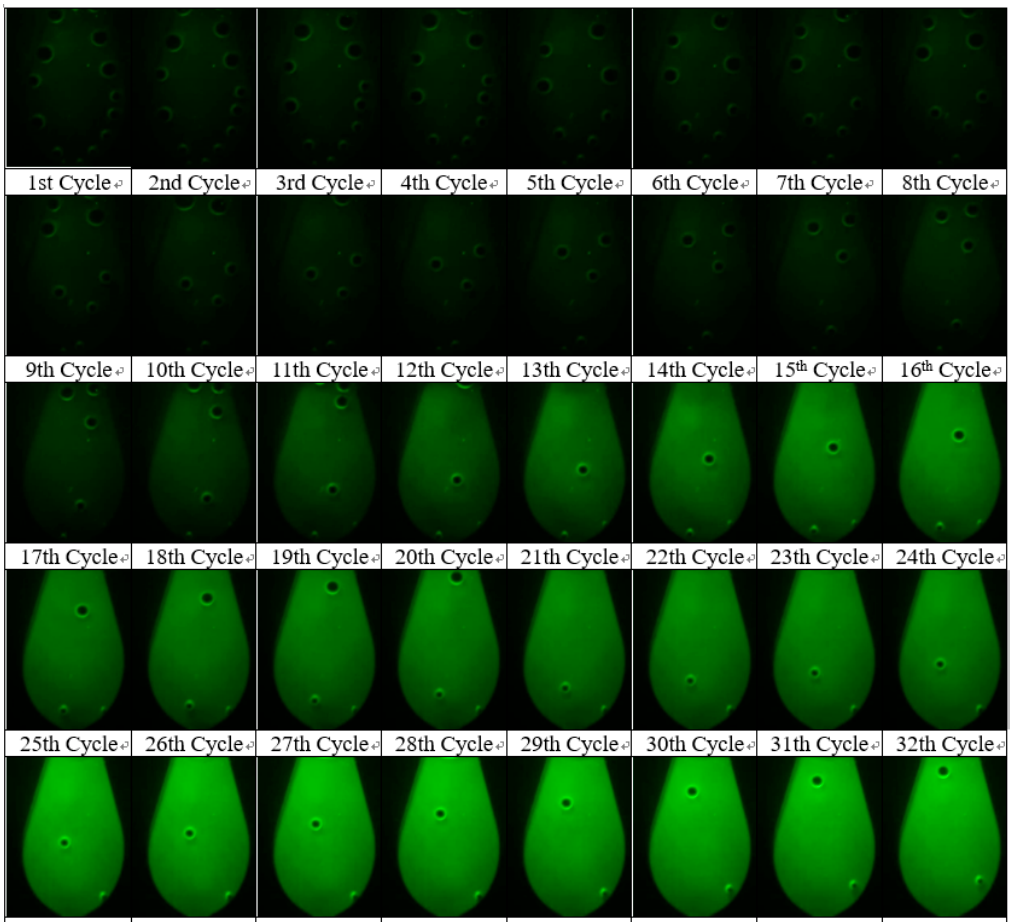
Figure 5. RT-PCR result images of CT DNA obtained every PCR cycle at a concentration of 0.1 ng/µL.